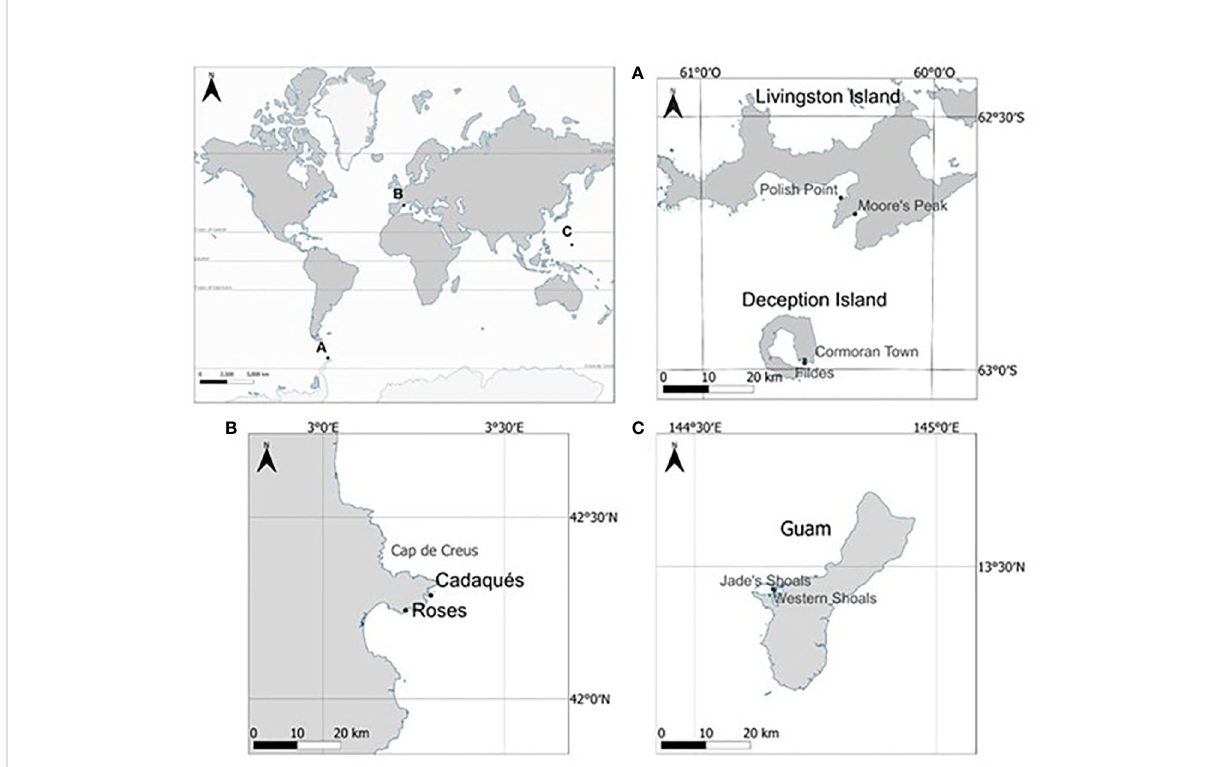
FIGURE 1 Sampling sites of the different regions. (A) Antarctic region (South Shetland Islands). (B) Mediterranean region. (C) sampling sites in Guam Island (Mariana Islands). Sampling locations are marked with black dots at each sampling